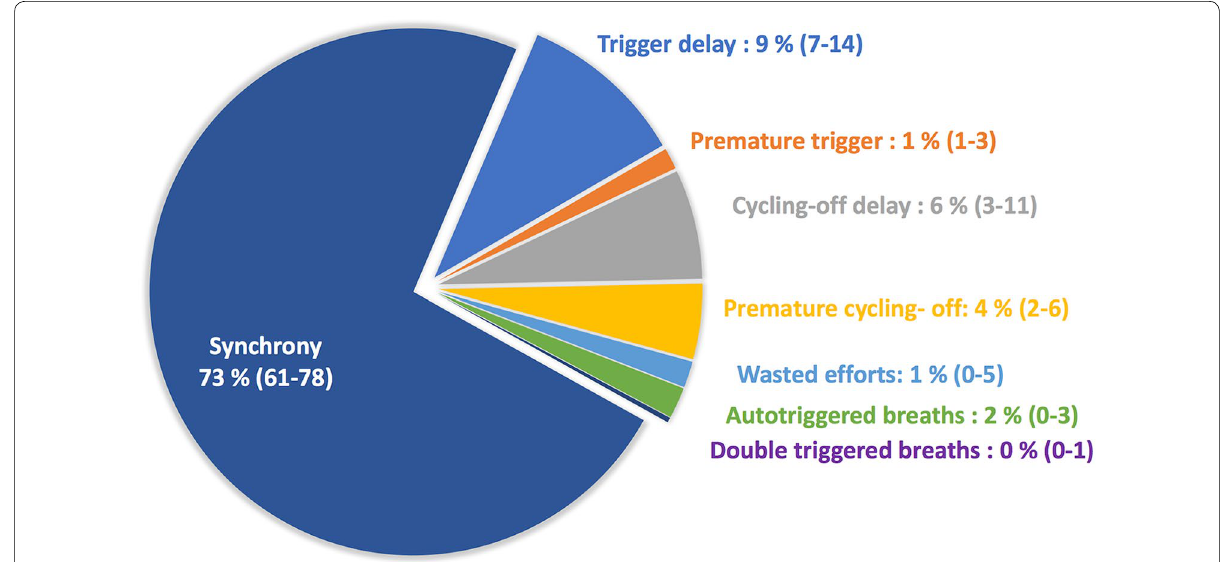
Fig. 2 Contribution of the different types of asynchrony in the total time spent in conflict with the